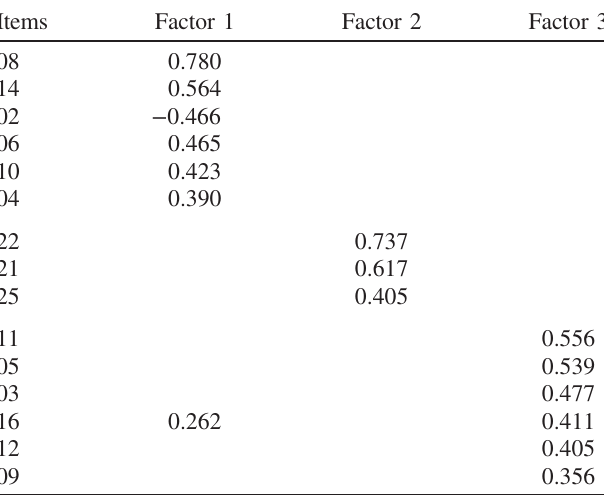
TABLE III. Initial three-factor loadings for group A. Loadings less than 0.25 have been suppressed. EFA involved approxi- mately half of the section 1 students. These loadings represent results after a filtering of the original 30 items.